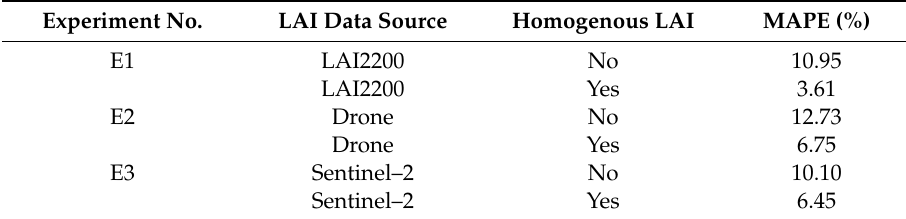
Table 2. Performance of SIMRIW–RS based on weather station